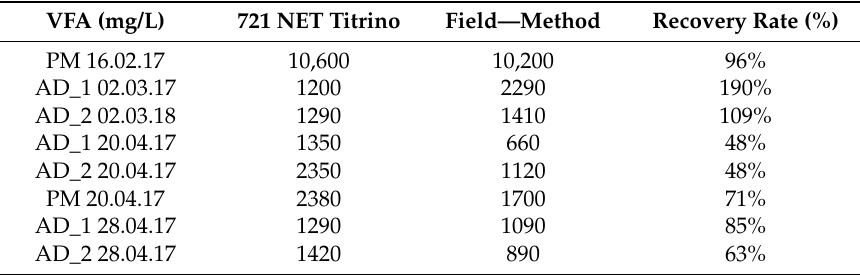
Table A7. VFA titration results, PM—pig manure; AD—anaerobic digestion effluent.